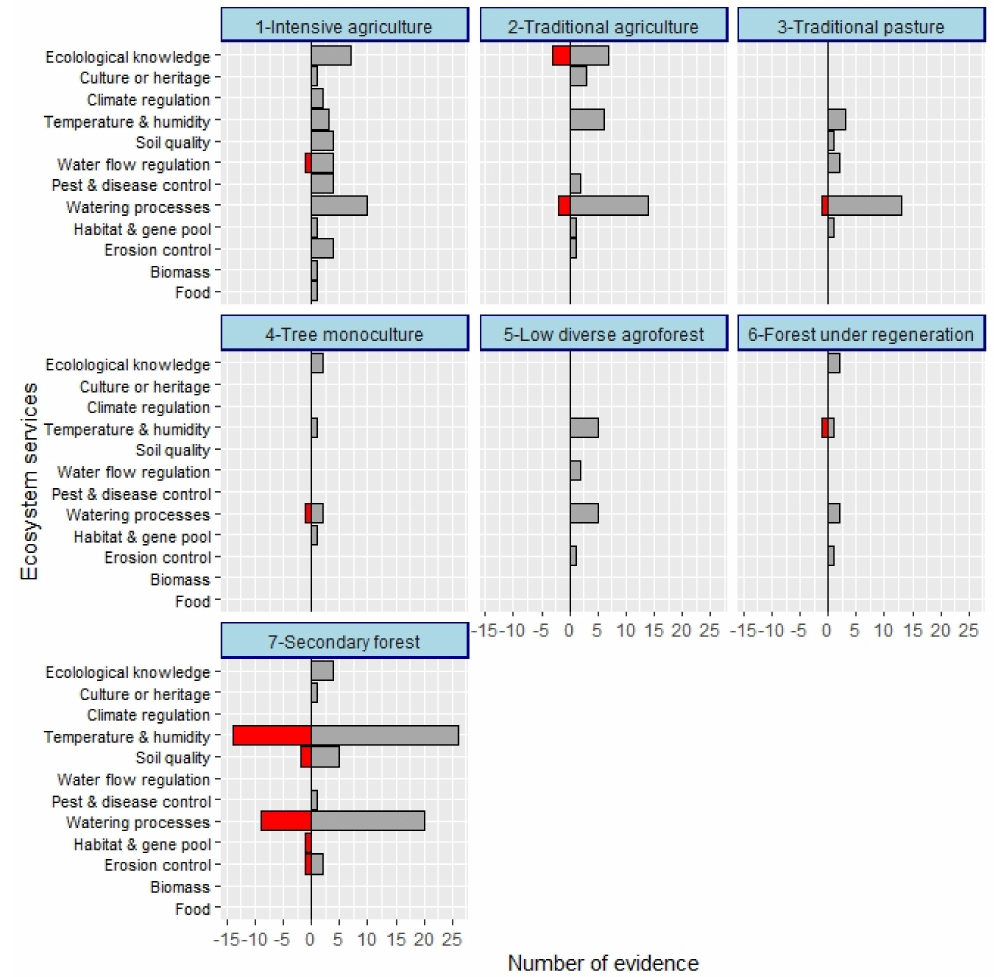
Figure 4. Number of items of evidence of positive and negative effects of agroforestry systems on ecosystem services in comparison with seven different land use & land cover types (full metadata in File